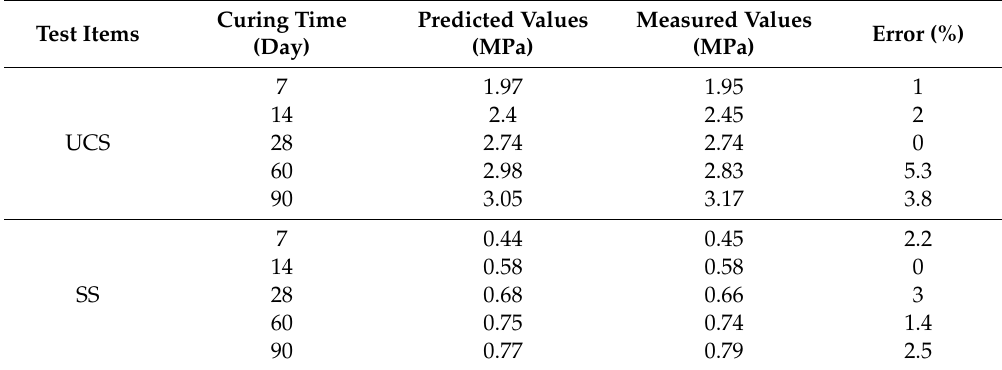
Table 6. The comparison of predicted and measured values of UCS and SS of